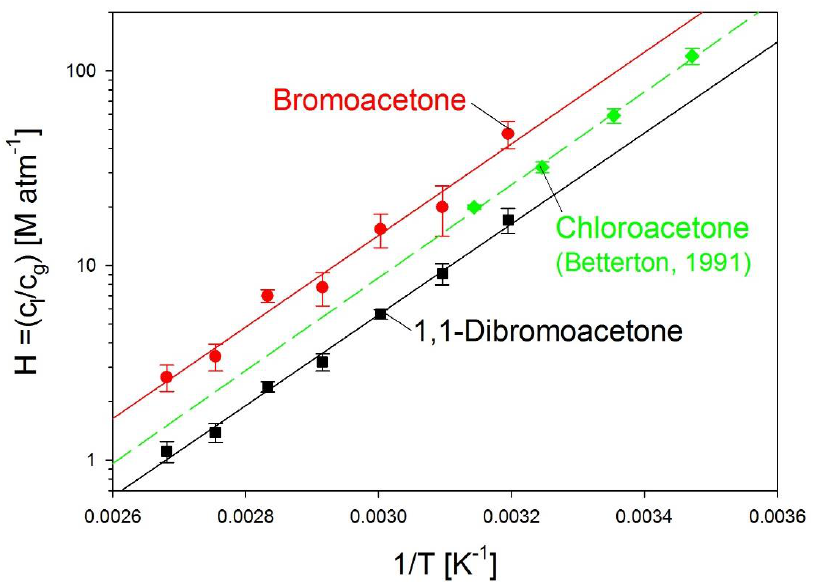
Figure 10. Temperature dependence of the Henry’s Law constants of bromoacetone (H 293 K = 133 ± 39 M atm −1 ), 1,1-dibromoacetone (H 293 K = 51 ± 11 M atm −1 derived from our data in Table 2) and of